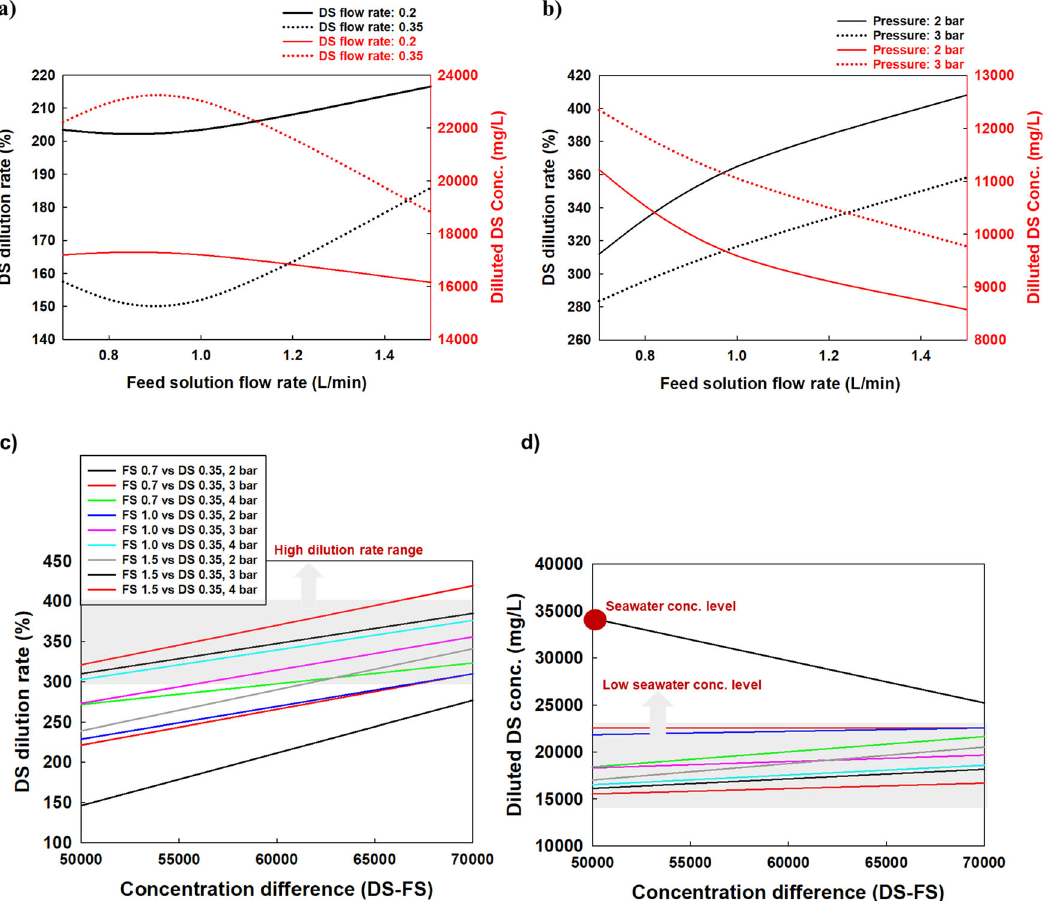
Fig. 3 DS dilution rate and concentration at various operation conditions. Panels a , b show the DS dilution rate and concentration at the FO and PAO mode operation. Panels c , d show the DS dilution rate and concentration with varying concentration differences between FS and